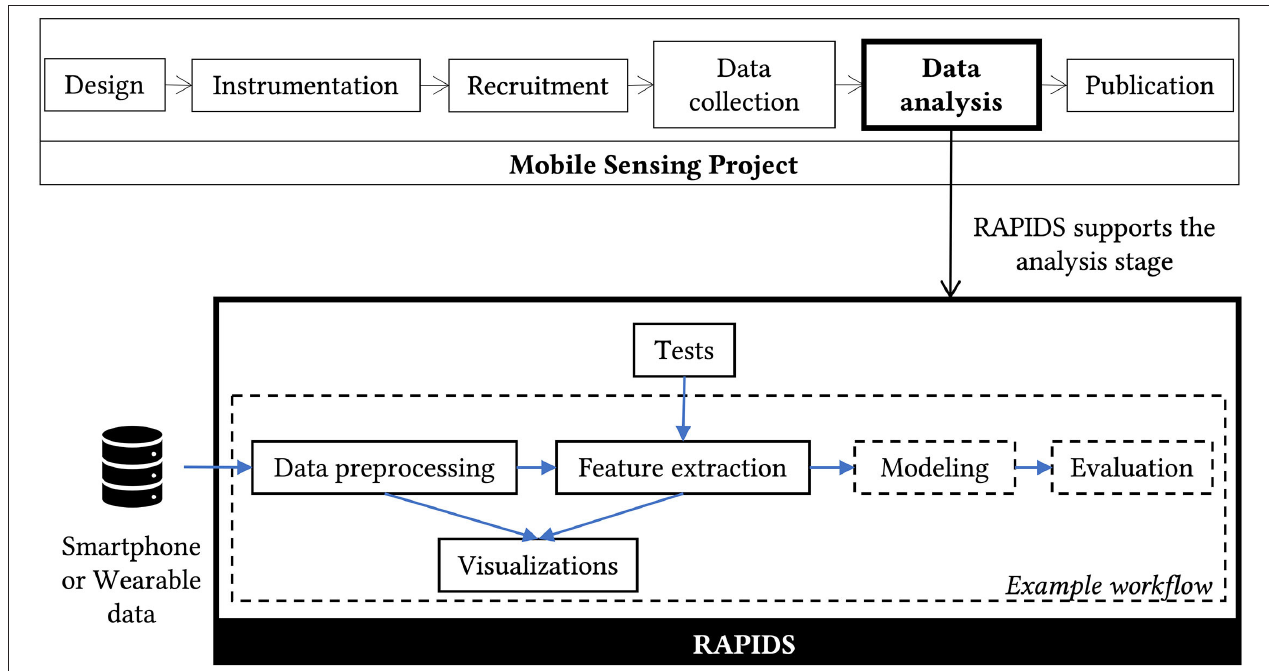
FIGURE 1 | RAPIDS supports researchers during the data analysis phase of a mobile sensing project. RAPIDS scripts can be categorized by purpose, those with a continuous border are reusable by other projects while those with a dashed border are provided as an example so other researchers can implement their own analysis.